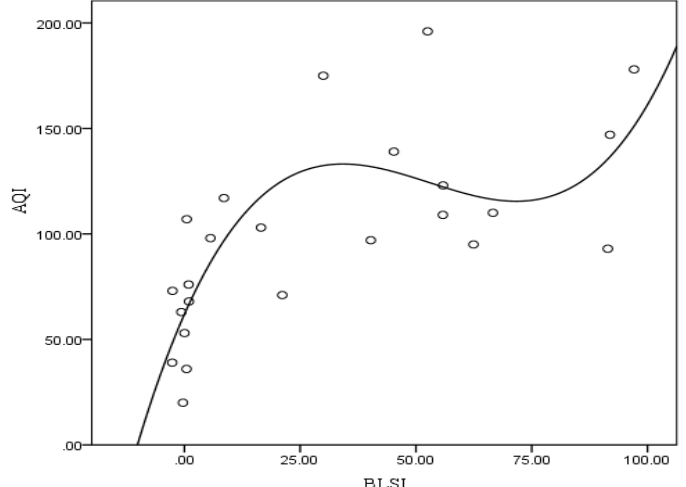
Atmosphere 2018 , 9 , x FOR PEER REVIEW Figure 11. Regression curve of BLSI (multiply by 10 3 ) and AQI. Figure 11. Regression curve of BLSI (multiply by 10